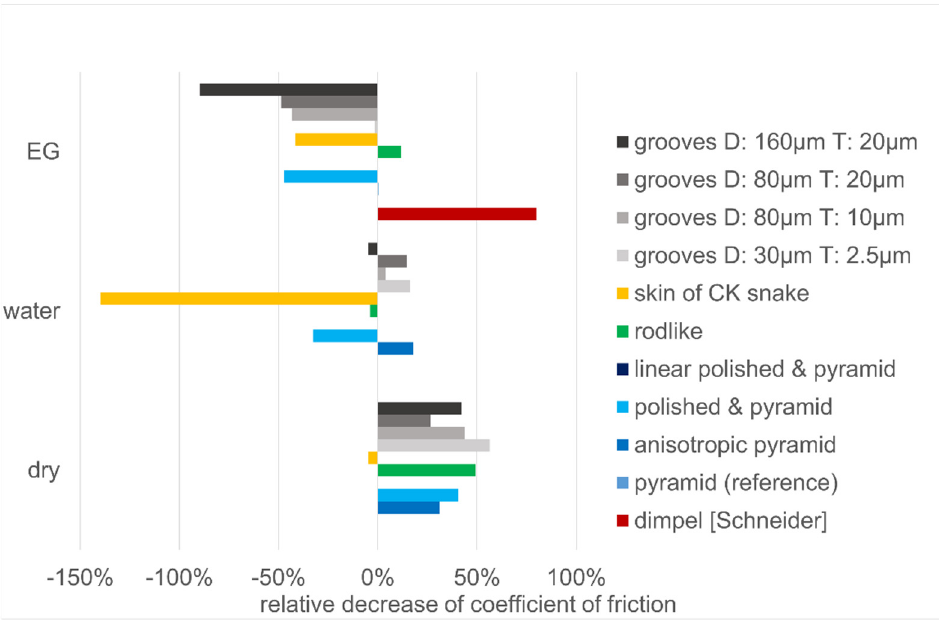
Figure 12. Overview of the friction coefficient reduction for differently structured surfaces under the three test conditions (dry/water/ethylene glycol (EG)): dry and the comparison with lubricated systems for friction coefficient reduction.